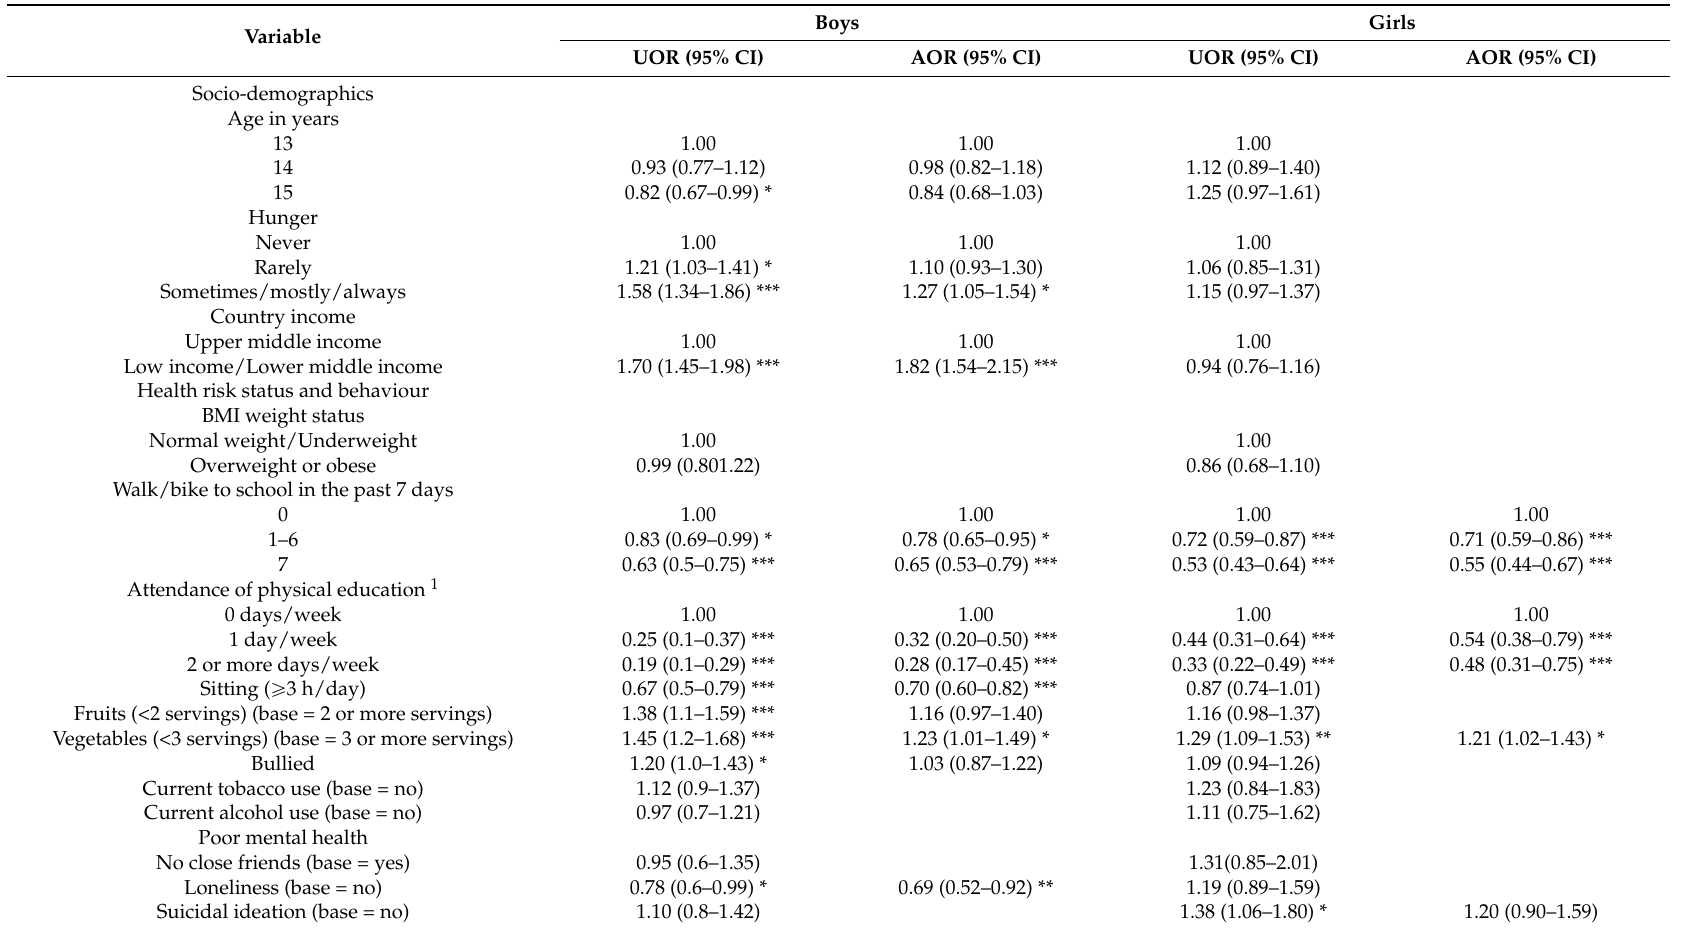
Table 5. Associations between physical inactivity prevalence, health behaviour, mental health and protective factor variables in school going adolescents by gender from 7 ASEAN